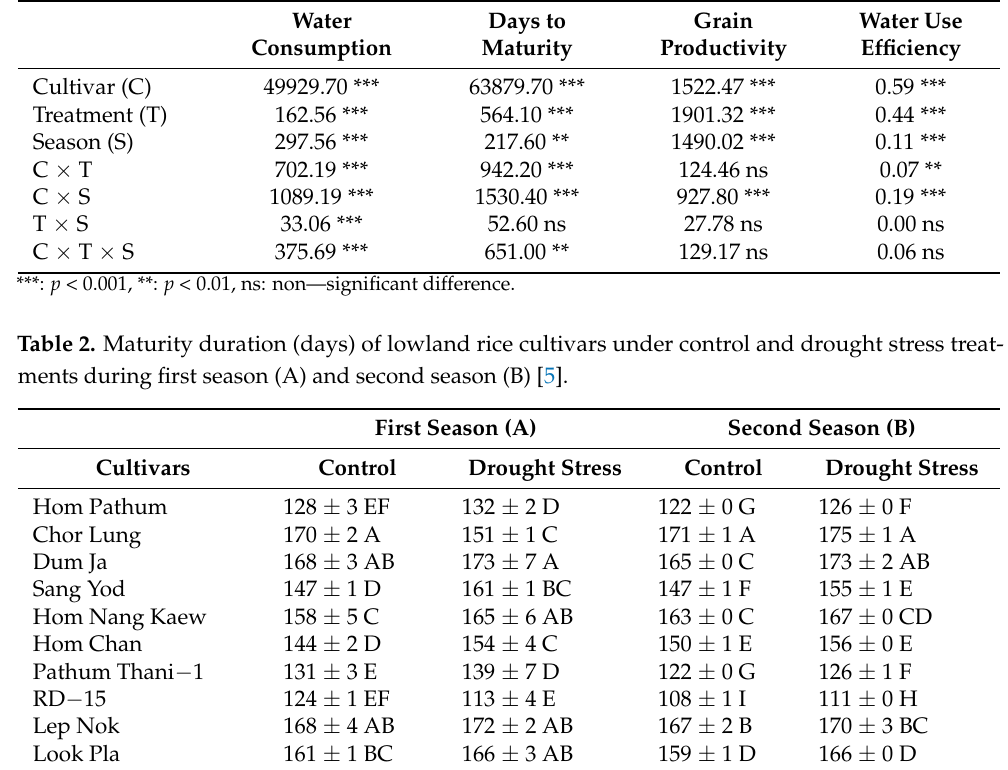
Table 1. Significance and sum of squares obtained from analysis of variance for water consumption, days to maturity, grain productivity and water use efficiency of lowland rice cultivars. Water Days to Grain Water Use Consumption Maturity Productivity Efficiency Cultivar (C) 49929.70 *** 63879.70 *** Treatment (T) 162.56 *** 564.10 ***